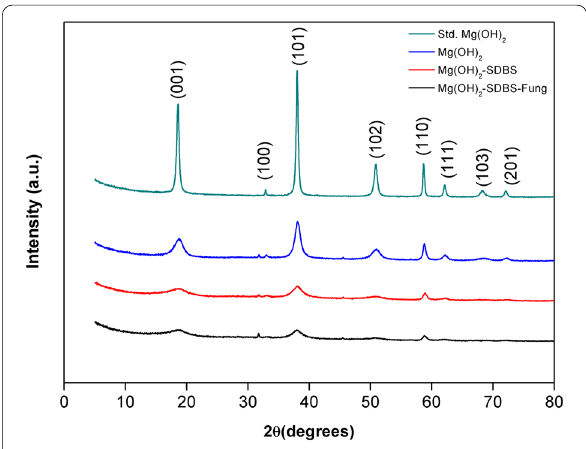
Fig. 5 XRD patterns of blank Mg(OH) 2 , Mg(OH) 2 -SDBS, and Mg(OH) 2 -SDBS in the presence of fungicides (100 μg/L each)